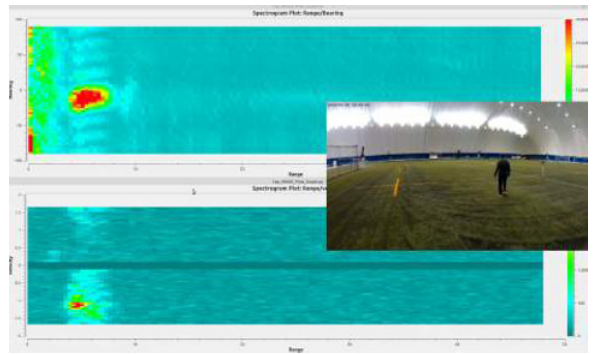
Figure 10. TDM MIMO mode real-time display of range vs. bearing on top, range vs. velocity on the bottom and an inserted photograph of the target and environment